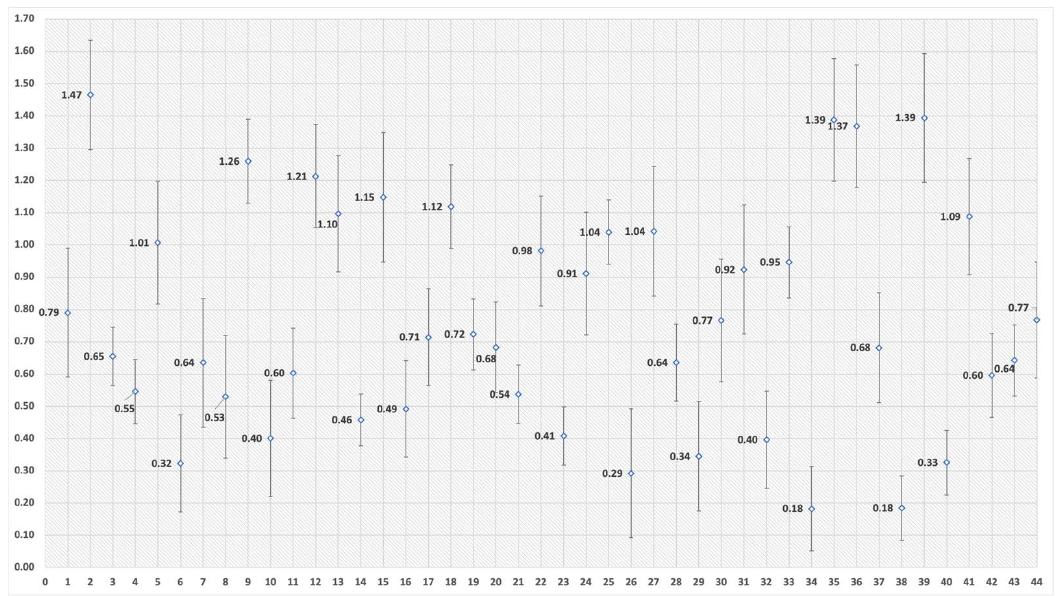
Figure 9. Performance of the LSTM network in indoor localization. The horizontal axis indicates the point of measurement while the verical axis indicates the average distance and standard deviation across all the measurements for an individual spot.